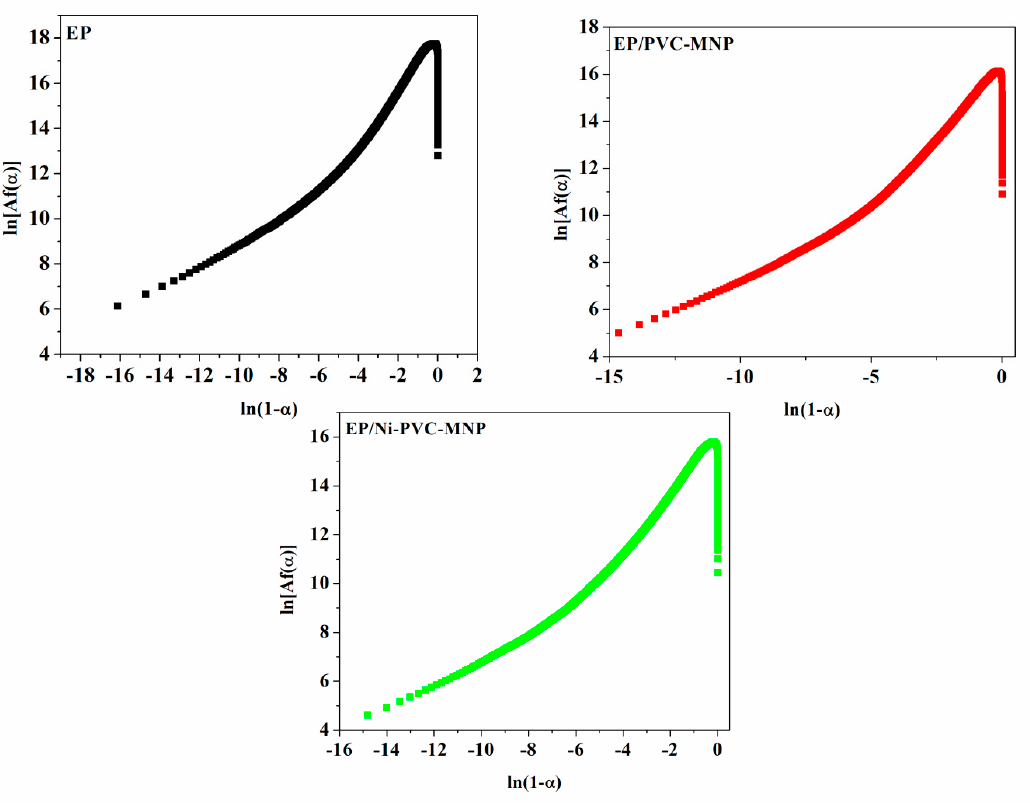
◦ C / min via Friedman